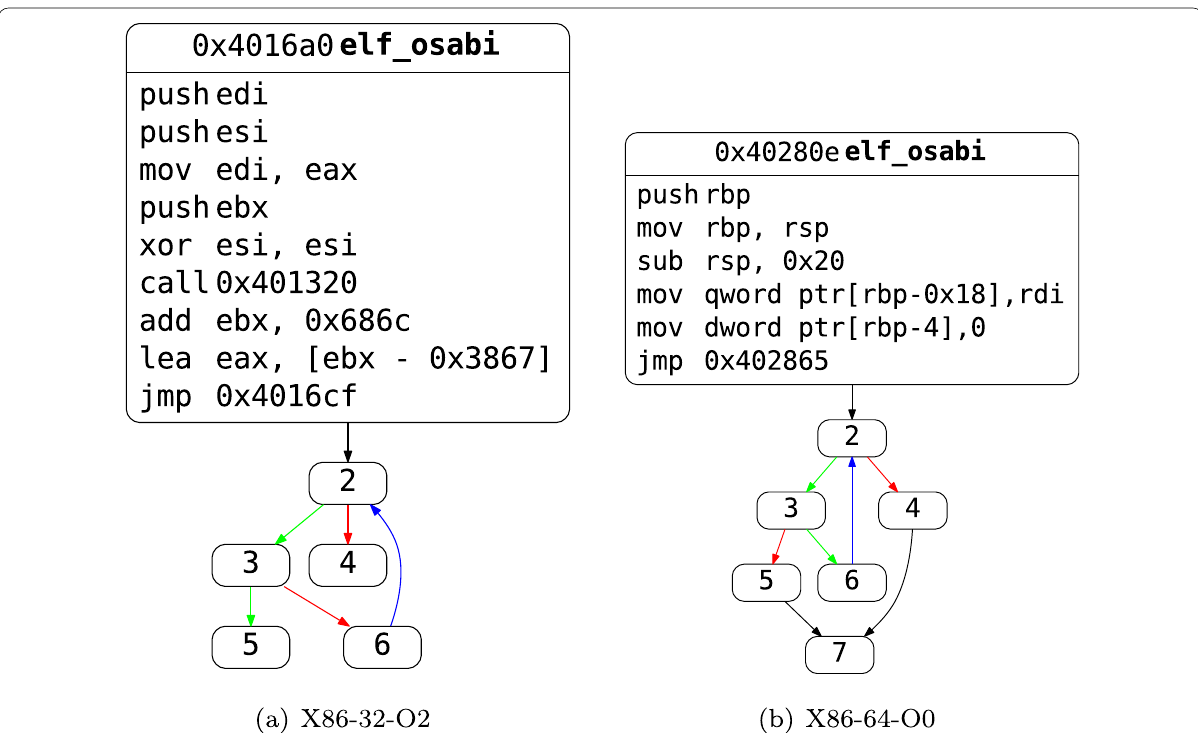
Fig. 1 Motivating example: the control flow graph and assemble code for the elf_osabi. The code block 0x4016a0 in a and the code block 0x40280e in b give the different assembly code blocks. The code blocks 2, 3, 4, 5, 6 and 7 in a and b represent the different code blocks respectively. Note that 2, 3, 4, 5, 6 in a and 2, 3, 4, 5, 6 in b are not the same block